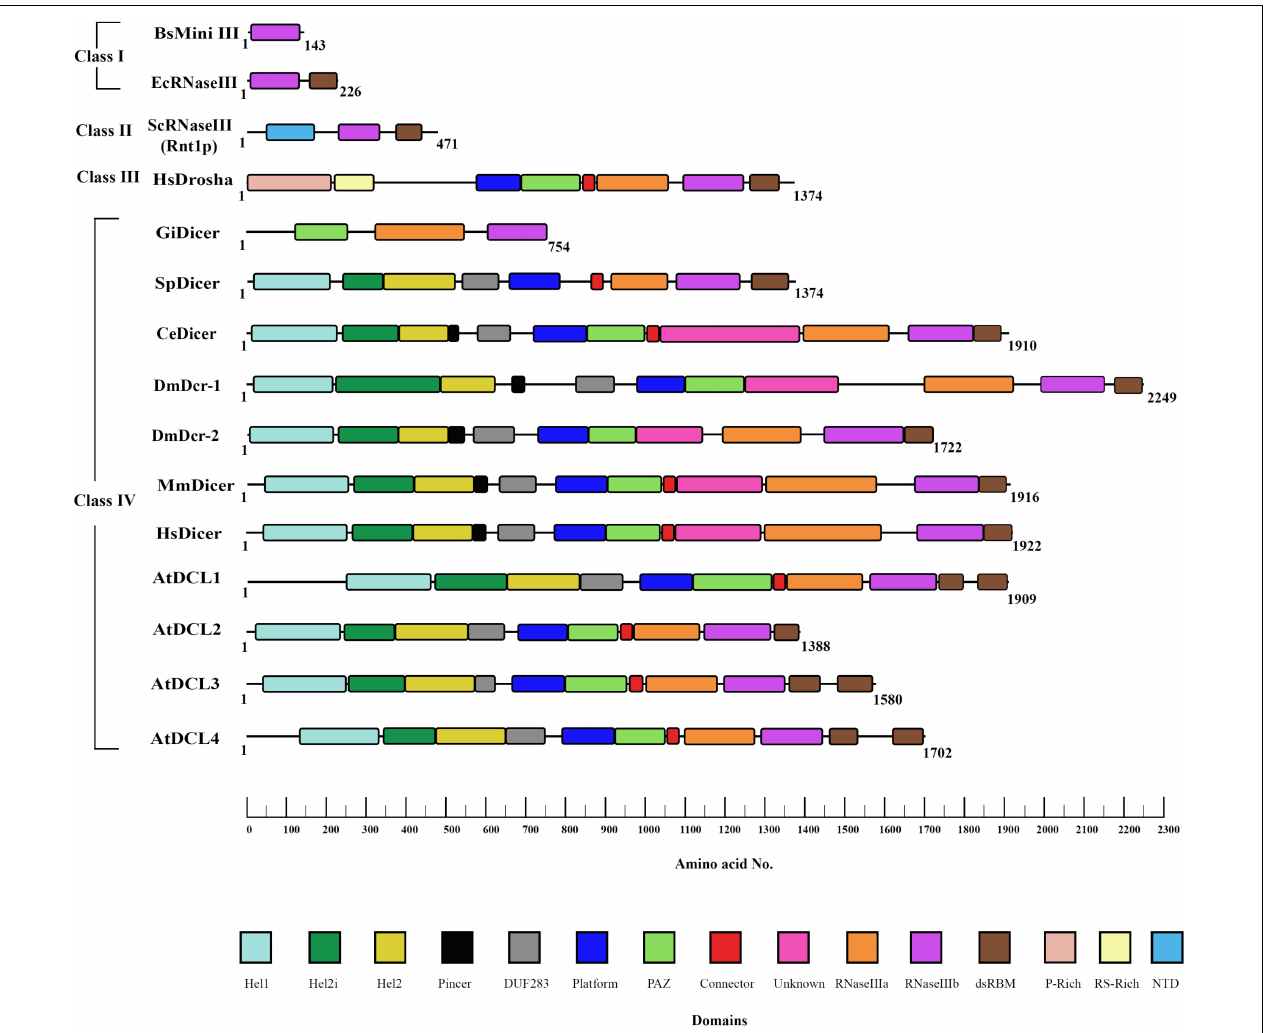
FIGURE 2 | RNase III family of proteins. RNase III proteins are classified into four distinct classes based on the domain architectural complexity. Bacteria like E. coli and fungi like S. cerevisiae contain the simplest RNase III enzyme that belongs to class I and class II, respectively. Class III consists of Drosha with P-rich and RS-rich domains unique to this class of proteins mediating cleavage of primary-miRNA transcripts as seen in humans and Drosophila . Class IV consists of an evolved Dicer family of proteins. Although belonging to fungi, S. pombe has more evolved Dicer as compared to that of other fungal species. However, it lacks the PAZ domain essential for RNA recognition. The innovative domain shuffling of various domains in Dicer is evolved to respond to the needs of the species and changing environmental conditions. The domain boundaries were defined by Phyre-based homology modeling, conserved sequences of domains, and available X-ray, NMR, and cryo-EM